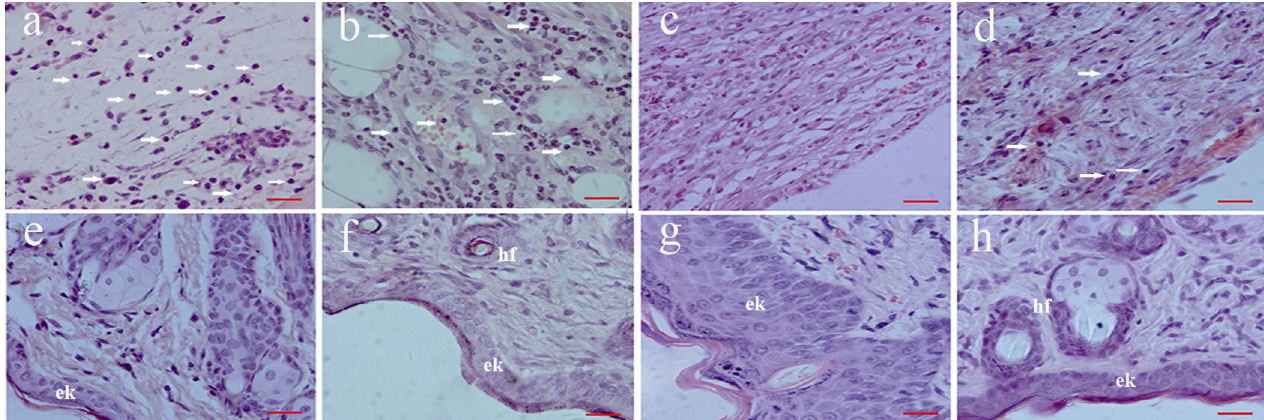
Fig 10. Hematoxylin-eosin–stained sections of mice in the protoporphyrin IX–ethylenediamine derivative-mediated photodynamic antimicrobial chemotherapy (PPIX-ED-PACT) and control groups on days 7 and 14 after treatment. (a, e) Control group on days 7 and 14, respectively; (b, f) 50 μ M PPIX-ED-PACT group on days 7 and 14, respectively; (c, g) 100 μ M PPIX-ED-PACT group on days 7 and 14, respectively; and (d, h) 200 μ M PPIX-ED-PACT group on days 7 and 14, respectively. Images were taken at × 400. Scale bars, 20 μ M. White arrows: inflammatory cells. (e, k) Epidermal keratinocytes and (h, f) hair